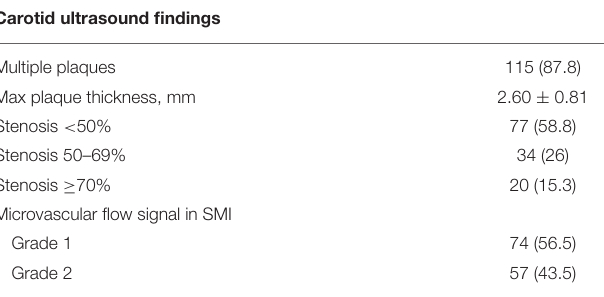
TABLE 2 | Plaque characterization by ultrasonography.